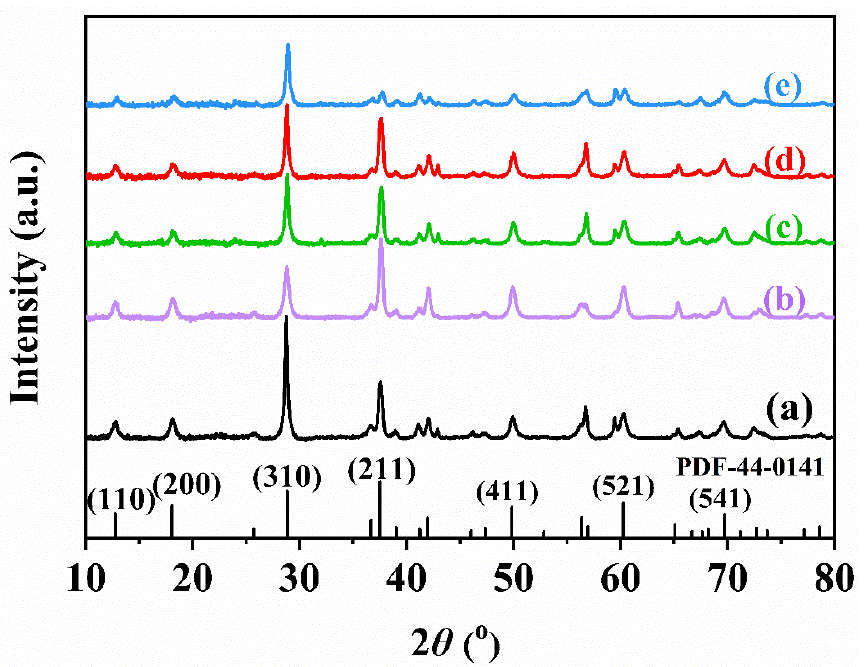
Figure 2. XRD patterns of (a) α -MnO 2 , (b) 0.93Pt/ α -MnO 2 , (c) 0.91Pt-0.5rGO/ α -MnO 2 , (d) 0.94Pt- 1.0rGO/ α -MnO 2 , and (e) 0.92Pt-2.0rGO/ α -MnO 2 .